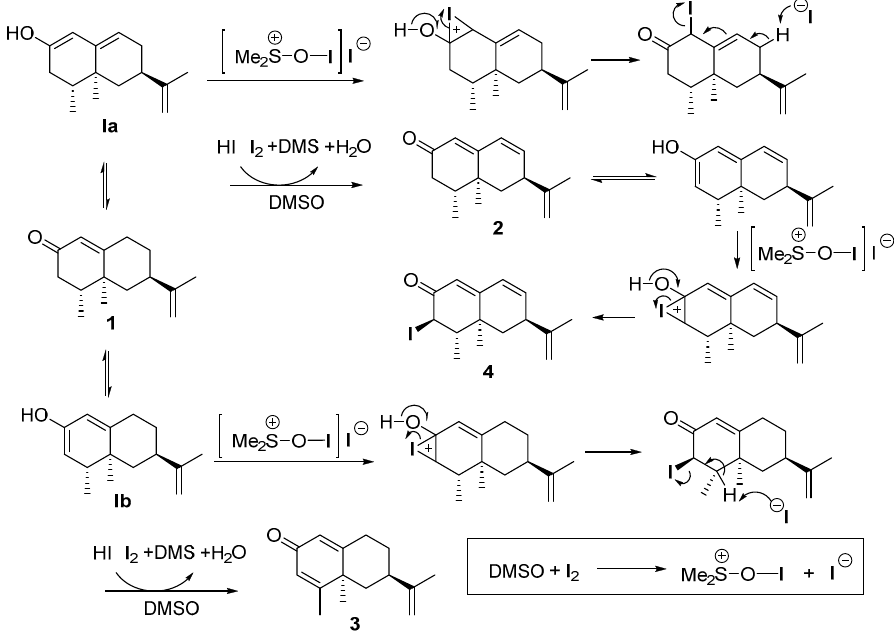
Table 1. Reaction of nootkatone with the dehydrogenating system I 2